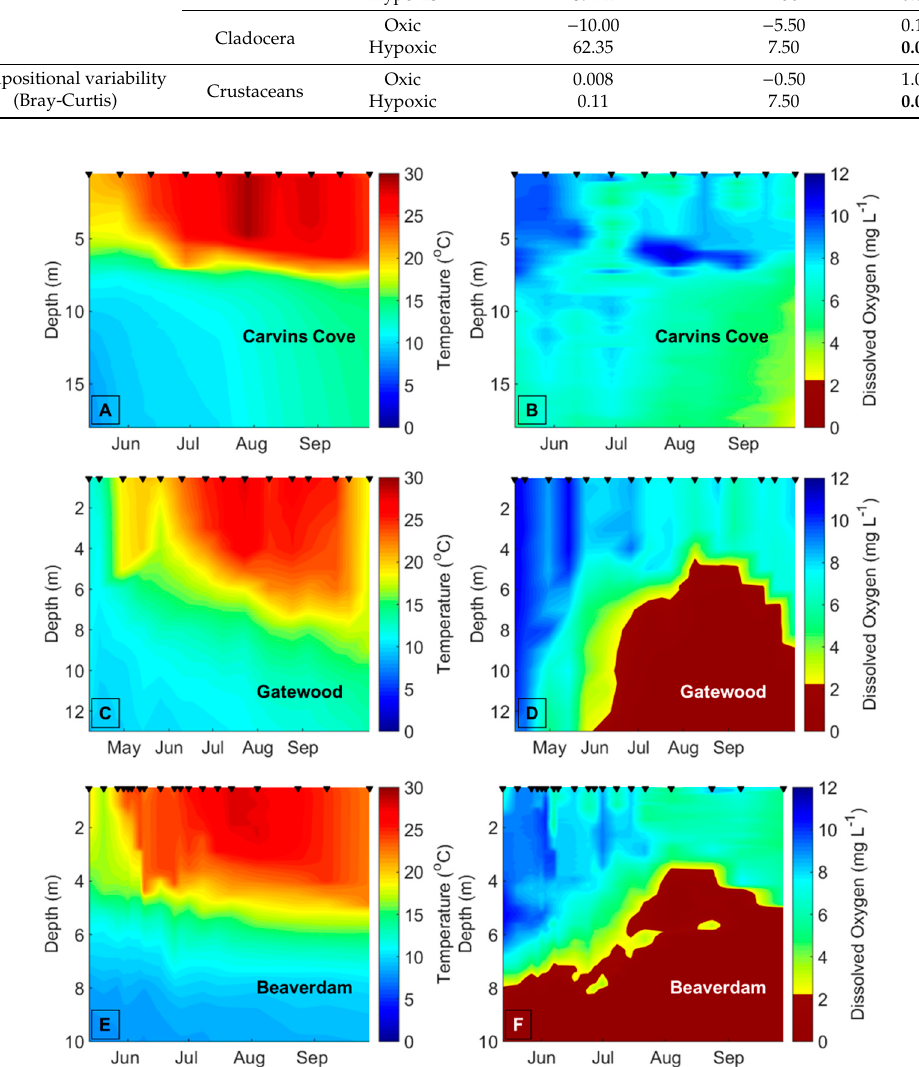
Figure A2. Temperature and dissolved oxygen depth profiles of the focal reservoirs during the summer stratified period in 2016. The color scale for the dissolved oxygen concentrations highlights the hypoxia threshold at 2 mg L − 1 . The hypolimnia of Carvins Cove ( A , B ) remained oxic; however, the hypolimnia of Gatewood ( C , D ) and Beaverdam ( E , F ) developed hypoxia. Black triangles on the top of each panel represent days sampled, and the intervening data were interpolated.